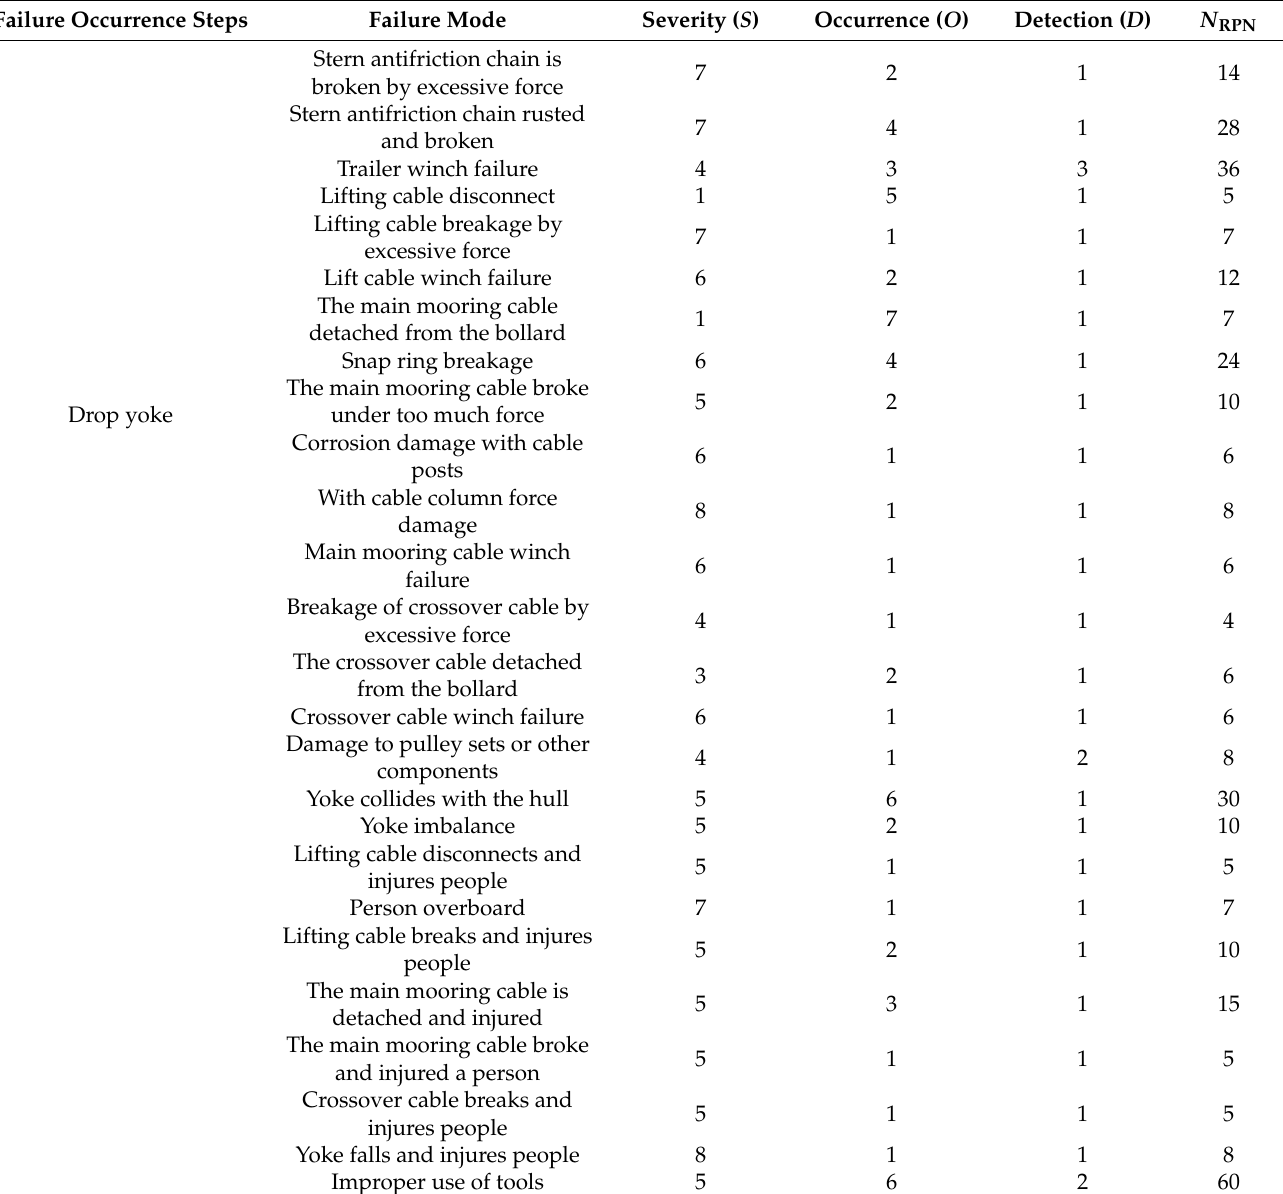
Table 4. Yoke dropping